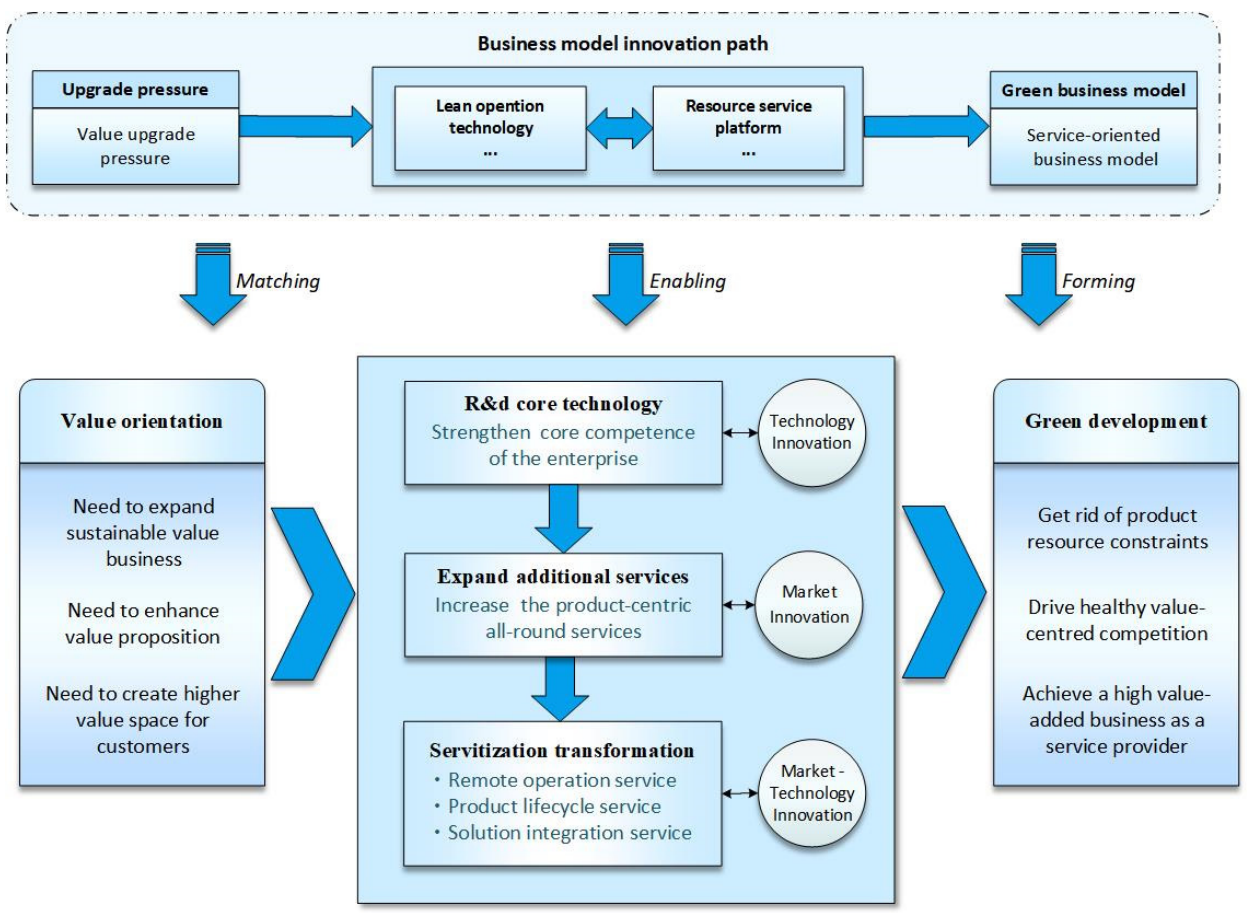
Figure 5. Conceptual model of the value-oriented path.